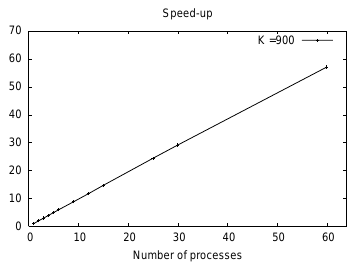
Figure 8. Computation time, in sec- onds, vs. the number of processes, for the McFadden problem with 900 spatial mesh points.